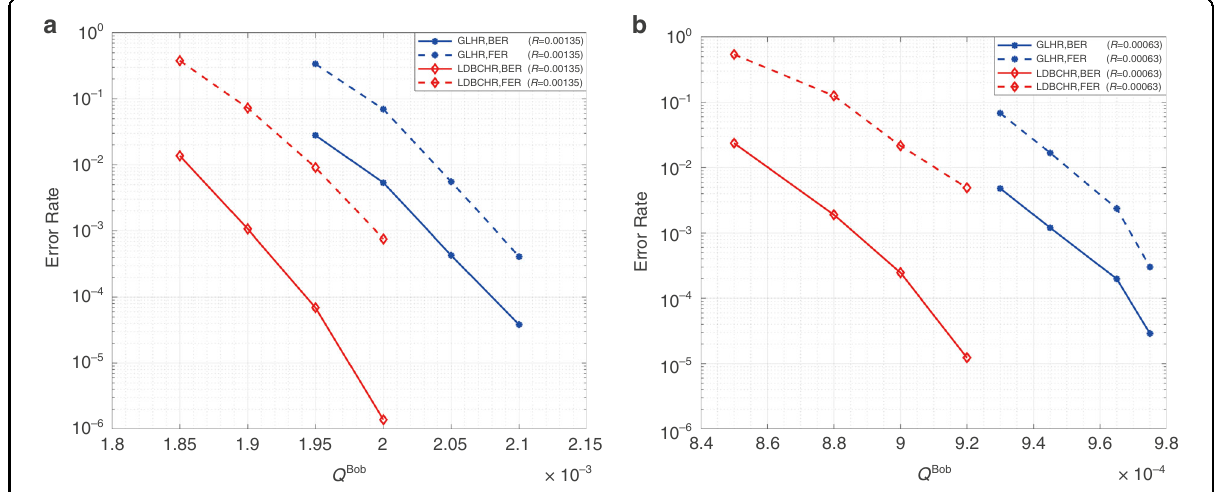
Fig. 6 Comparison of bit error rate/frame error rate performances between the GLHR and LDBCHR. a R = 0.00135; b R =